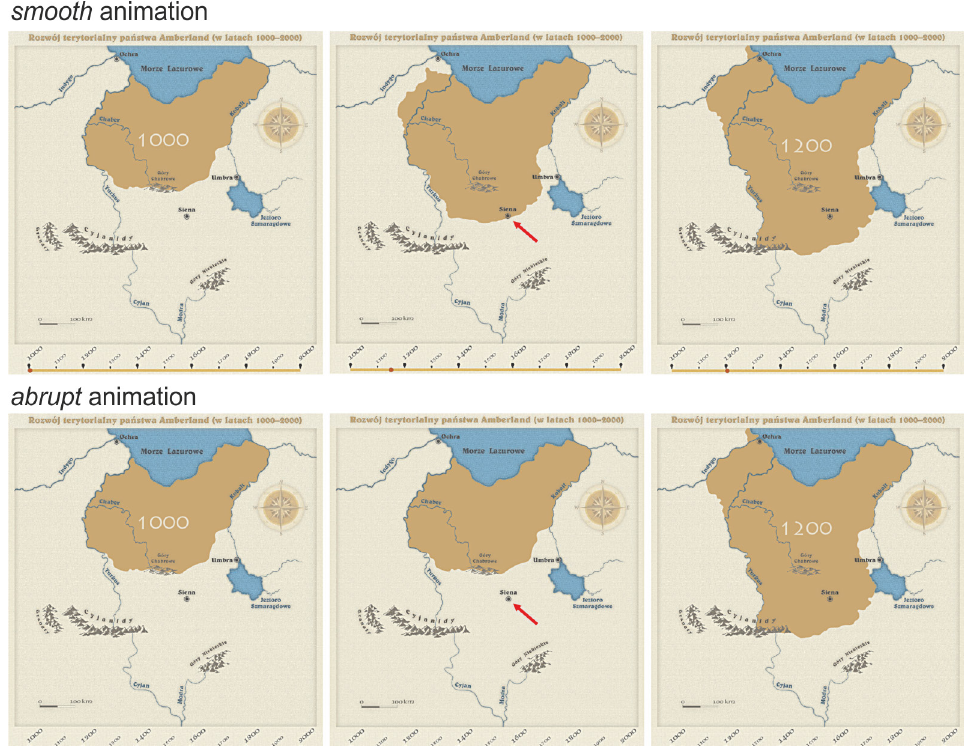
Fig. 1. The difference between smooth and abrupt animations illustrated on selected frames. In 1000 and in 1200 both ranges are identical, but between those set moments in time there are significant differences in the course of the state boundary (middle